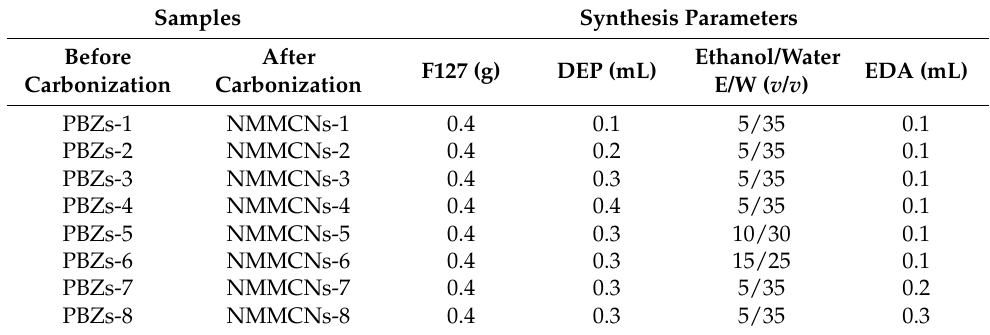
Table 1. The synthesis parameters of PBZs-x and